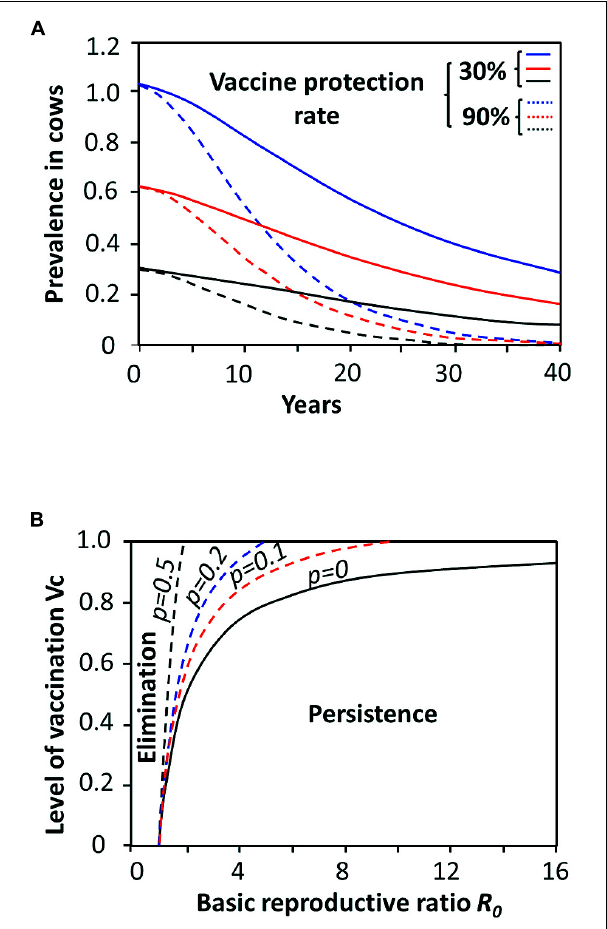
FIGURE 7 | Sceneries for vaccine performances against brucellosis according to various models. (A) Predicted model for bovine brucellosis eradication in Mato Grosso (blue), Rodôni (red), and Goiás (black) Brazilian States with different experimental prevalences using two vaccine protection rates. Protection rate by low-efficacy vaccines or low coverage vaccination are not capable to eradicate brucellosis in four decades (solid lines), independently of the initial prevalence.The critical threshold applies to both: (i) the proportion of the population that needs to be vaccinated, and; (ii) the protective quality of the vaccine (adapted from Amaku etal., 2009). (B) Prediction for the elimination or persistence or of brucellosis according to R 0 and the critical level of vaccination V c .The V c needed to protect a given population of animals is calculated by V c = 1 − 1/ R 0 .Those vaccines that fail to generate immunity in a fraction p of the immunized individuals, require higher coverage defined by R 0 − 1/ R 0 (1 − p ). However, if p is too big it may be impossible to eradicate the Brucella infection. Parameters such as culling of the infected animals and diminishing of the density of the susceptible animals have a significant impact in both (A) and (B) since by reducing the value of p (not shown).The solid black